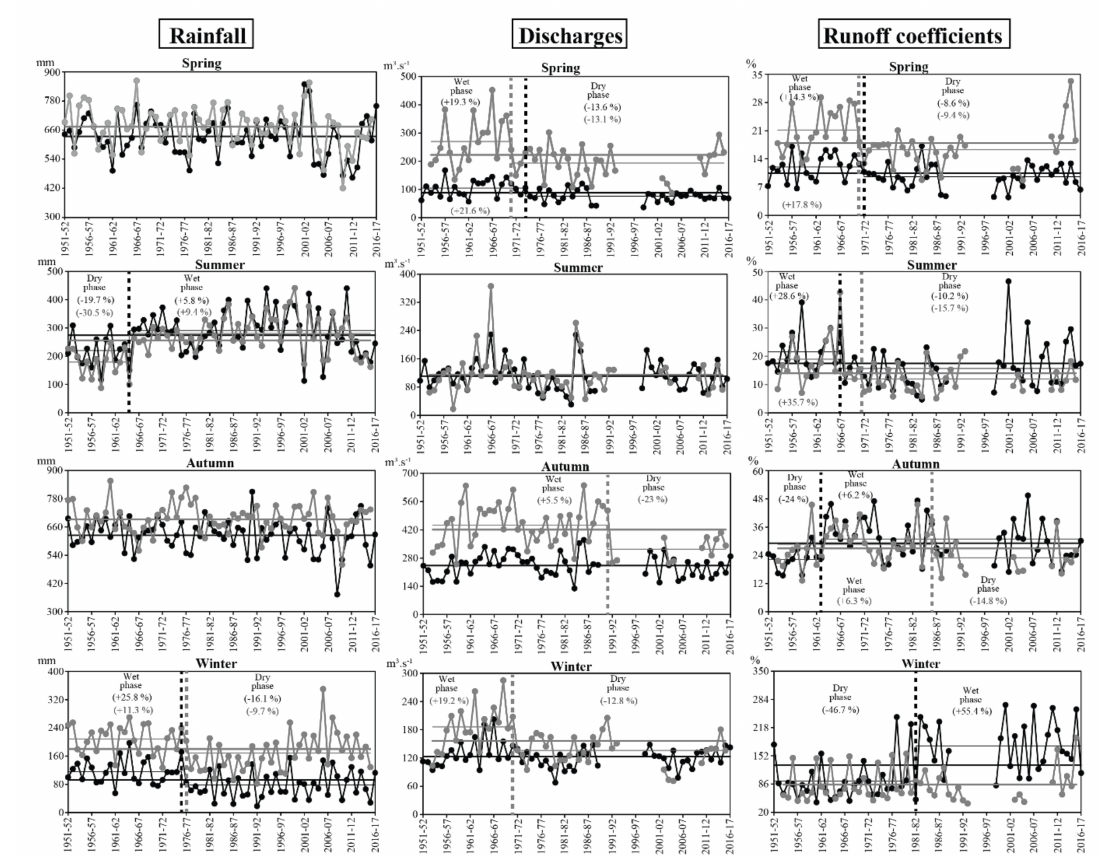
Figure 4. Results of statistical segmentation of Nyong (black) and Ntem (gray) seasonal rainfall, discharges and runo ff coe ffi cients, according to the Pettitt test. The thick horizontal lines indicate the averages of the whole period, while the thin horizontal lines indicate those of the di ff erent homogeneous periods. The thick and broken vertical lines indicate the years of